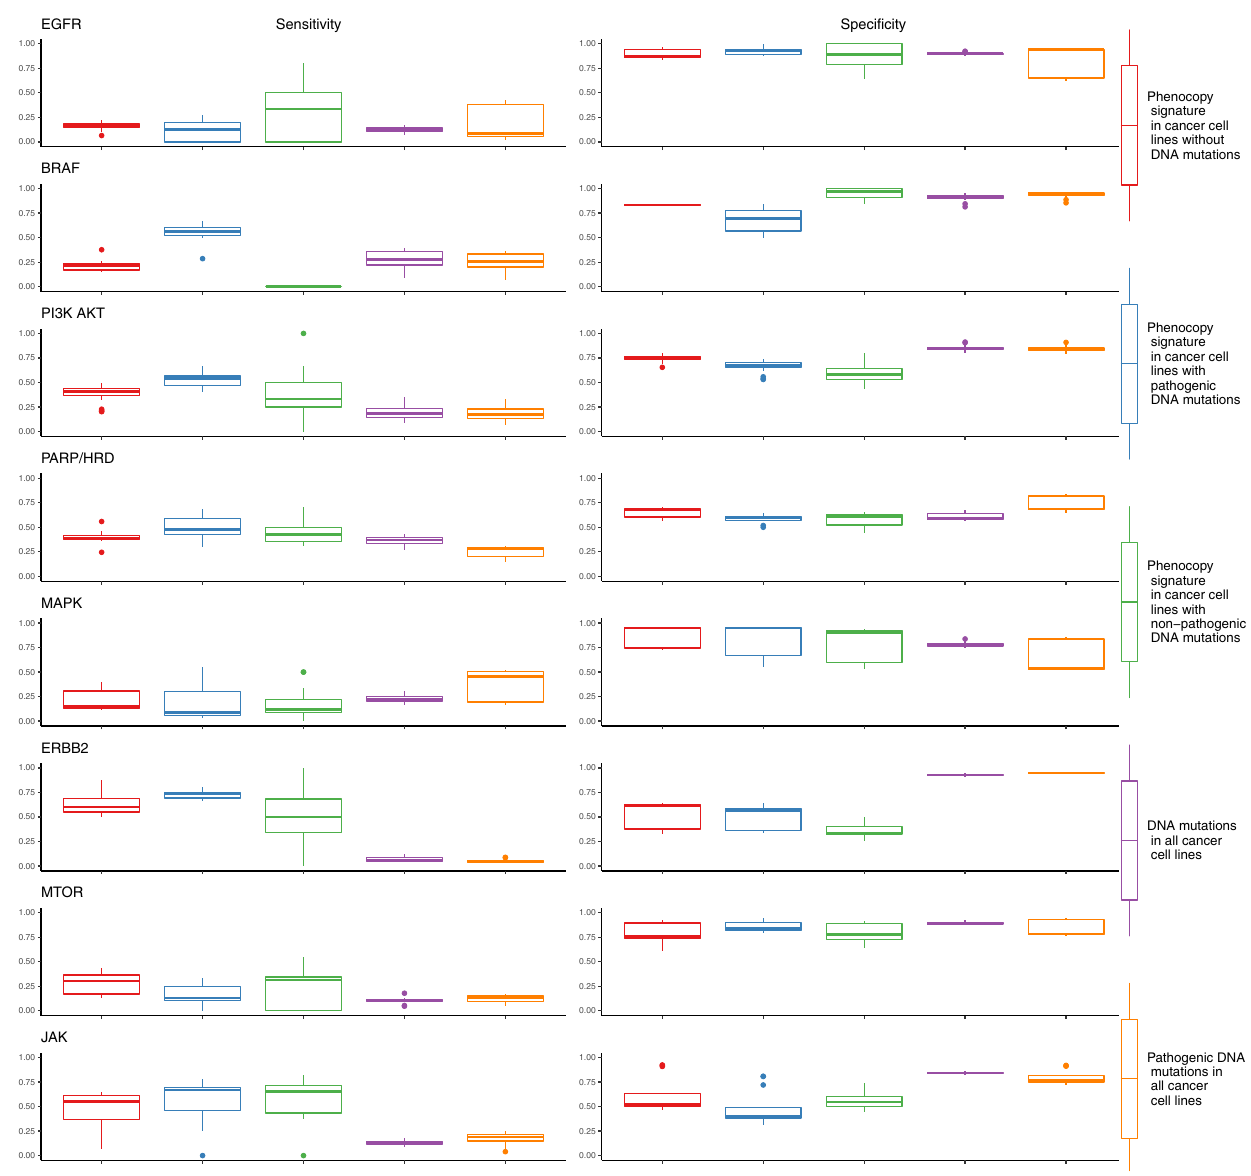
Fig. 4 Sensitivity and speci fi city of phenocopy signatures. Sensitivity and speci fi city were calculated for each combination of drug and pathway. The top quartile in drug sensitivity for each drug was considered a responder. Each data point represents a single drug in a single dataset, with the three datasets represented by different shapes. Five separate conditions were investigated: (1) Phenocopy signature in cancer cell lines without DNA mutations, (2) Phenocopy signature in cancer cell lines with pathogenic DNA mutations, (3) Phenocopy signature in cancer cell lines with non-pathogenic DNA mutations, (4) DNA mutations in all cancer cell lines, and (5) Pathogenic DNA mutations in all cancer cell lines. Boxplot center line = median value, bounds of box (hinges) = interquartile range (IQR), bounds of whiskers = maximum of 1.5X IQR from the EGFR, BRAF, and MAPK, and better than DNA alterations for PI3K- AKT, PARP/HRD, ERBB2, MTOR, and JAK. Oncogenic activation of ERBB2 (gene encoding HER2) in particular is thought to be heavily in fl uenced by ampli fi cation, and our results suggest that a mutational phenocopy signature may provide complementary information. The speci fi city of the phenocopy signatures was high across pathways in identifying responders in cell lines without DNA mutations (Fig. 4). The PPVs in cell lines without mutations are almost all improved compared to the results observed with DNA mutations, with the exception of BRAF in which the DNA mutations perform particularly well (Fig. 5). As with speci fi city, the NPVs are high for the phenocopy signatures across groups. These